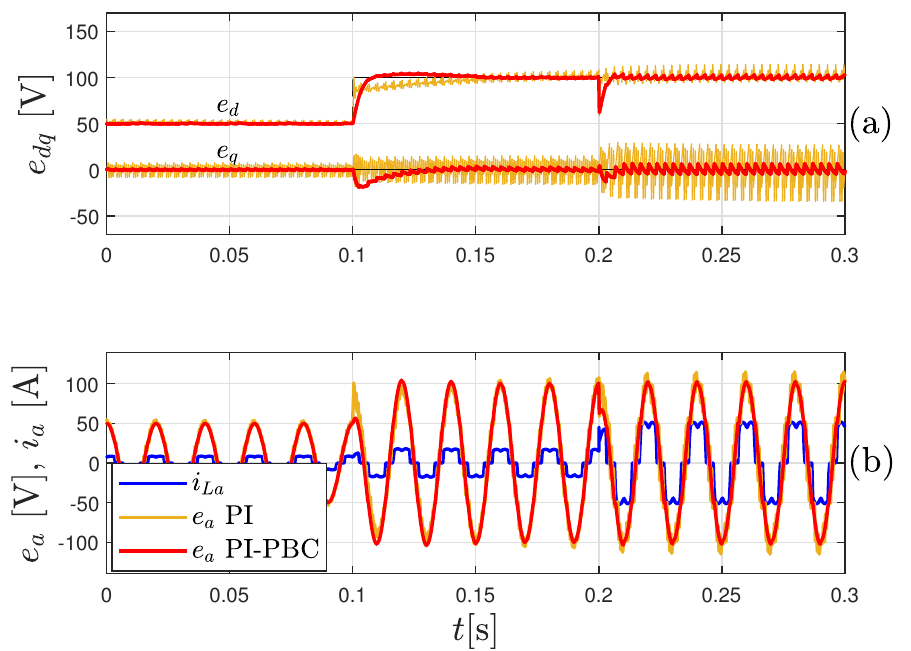
Figure 8. Test system behavior under very demanding conditions for the proposed controller (in red) and the classic PI approach (in yellow). ( a ) Voltage behavior in the Park’s reference frame. ( b ) Phase a voltage profile.